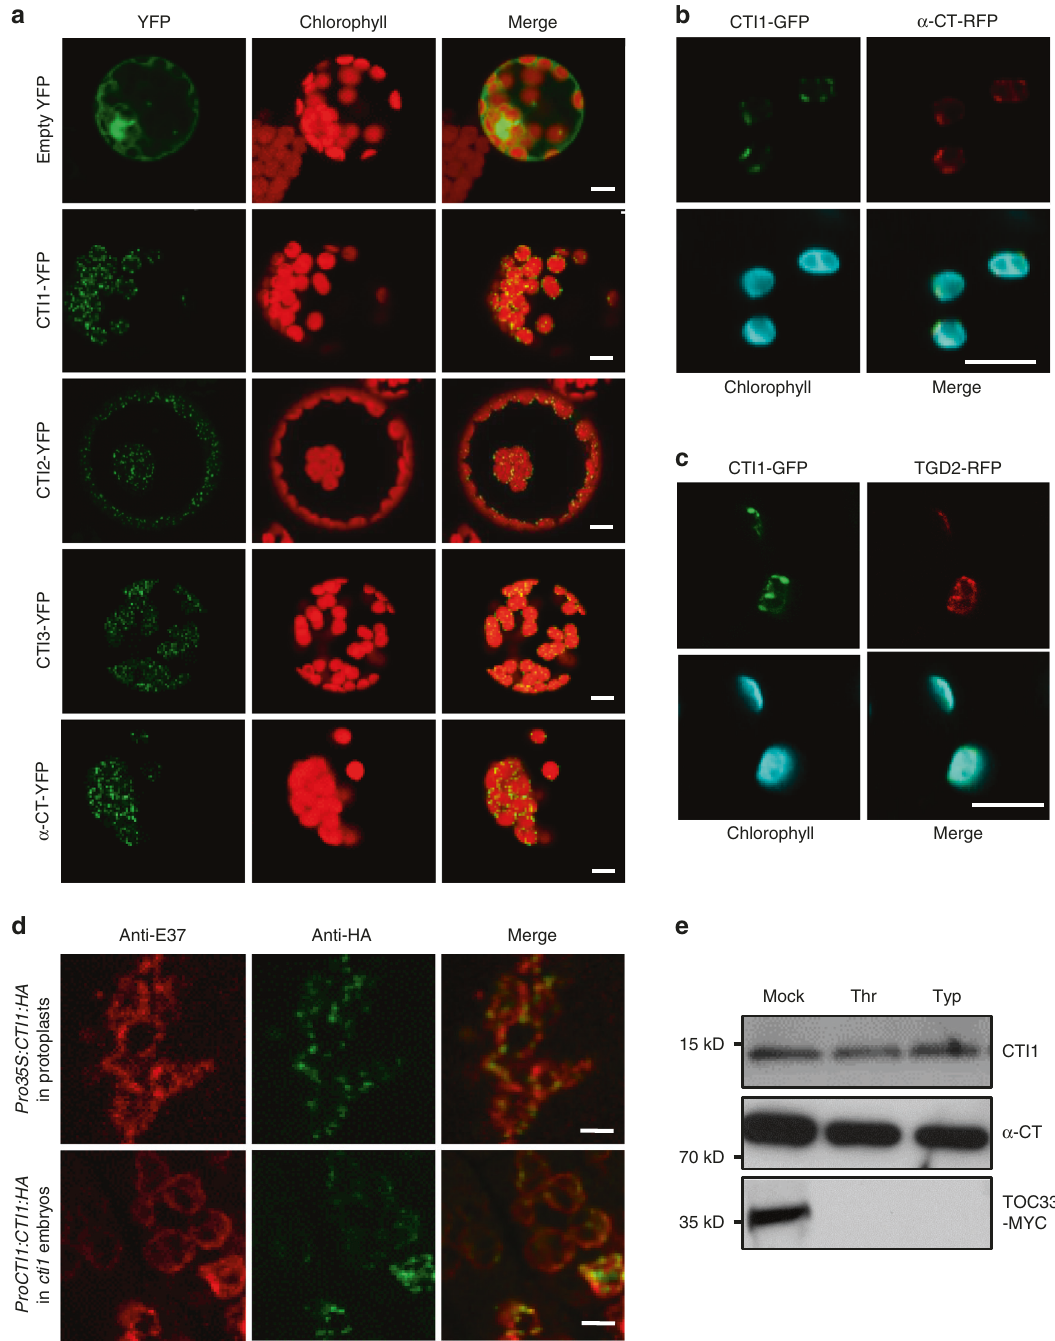
As a fi rst approach to study the impact of higher soluble htACCase activity in cti mutants, we determined the total fatty acid content in leaves of plants grown under long-day (LD) photoperiod. Consistent with increased FAS rate, leaf fatty acid content in the cti1 mutant was signi fi cantly higher than WT (a 22% increase). An additive effect of the cti mutations could be observed in double and triple mutants (Fig. 3e). The cti mutants also showed altered leaf fatty composition, with a decrease in the relative proportion of 18:3 polyunsaturated fatty acids and a concomitant increase in 18:0, 18:1, and 18:2 yielding a reduced desaturation ratio (Fig. 3f). Analysis of leaf lipid extracts by thin- layer chromatography (TLC) revealed accumulation of neutral lipids comigrating with TAGs in cti mutants (Fig.